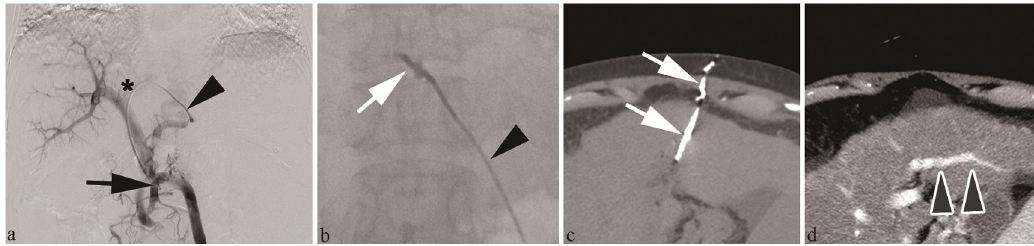
Fig 1. Hepatic tract embolization after percutaneous transhepatic sclerotherapy (PTS) in a 71-year-old woman with rectal varices. a) Portal venography obtained during PTS shows the catheter (black arrow) advanced through a 6-Fr sheath (black arrowhead) via the left branch of the portal vein (asterisk) under a transhepatic approach. b) Anterior radiography shows injection of gel-like radiopaque embolic material (white arrow) into the tract through the sheath (black arrowhead). c) Non-contrast- enhanced computed tomography (CT) confirms retention of radiopaque embolic materials (white arrows) in the hepatic tract. d) The contrast effect of the embolic material on contrast-enhanced CT disappeared 3 months after tract embolization. The left anterior portal branches visualized on contrast-enhanced CT (gray